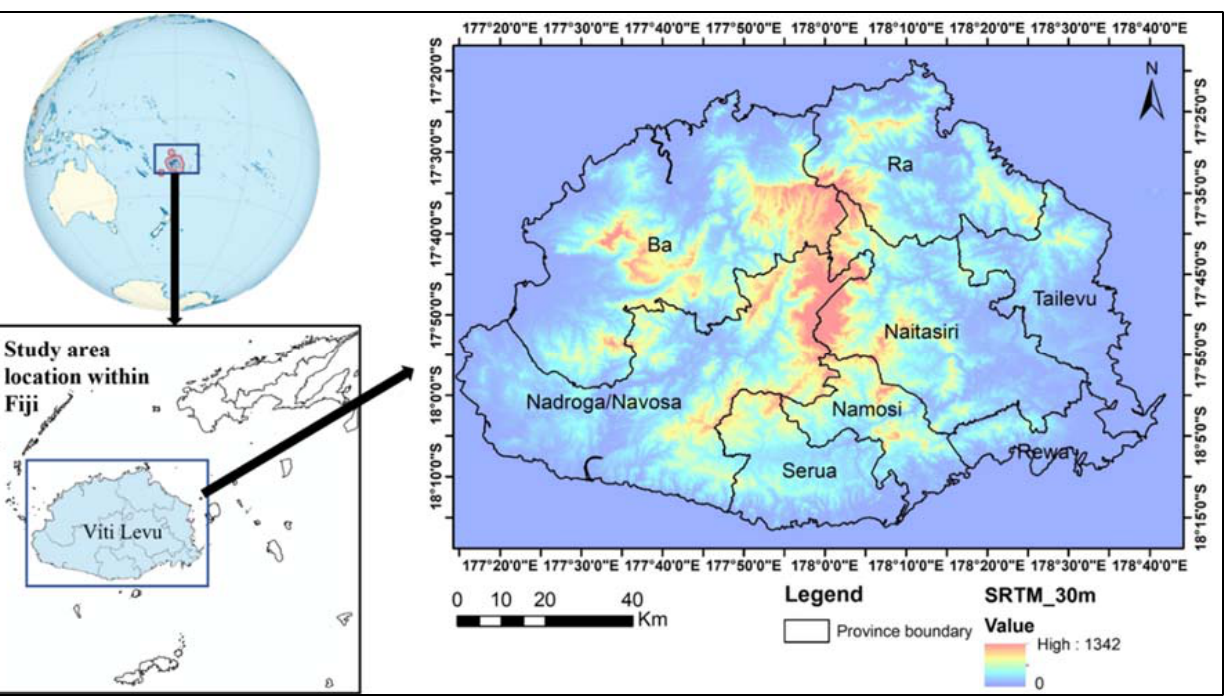
Figure 1. Map of study area located in Viti Levu Island.